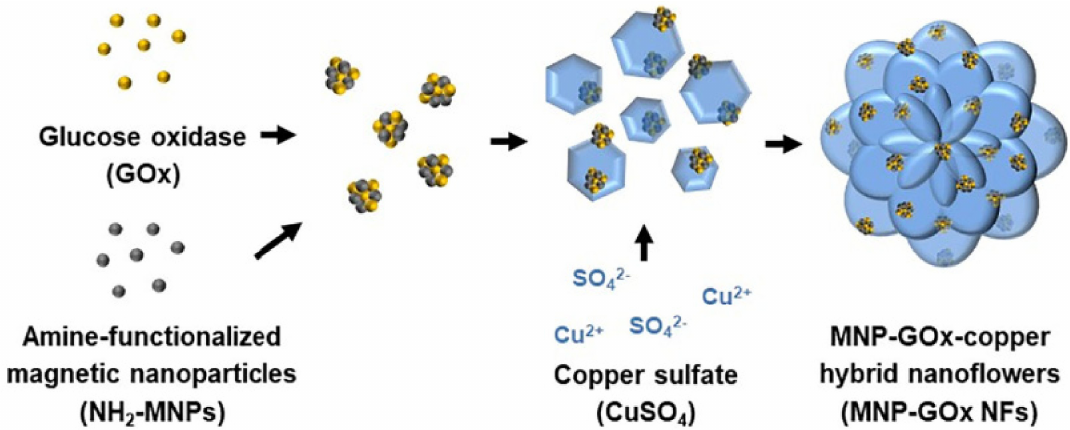
Figure 9. Preparation of MNP-GOx NFs. Reprinted from [111] with permission from Elsevier. Copyright © 2021 Elsevier B.V. License Number: 5031790647430.